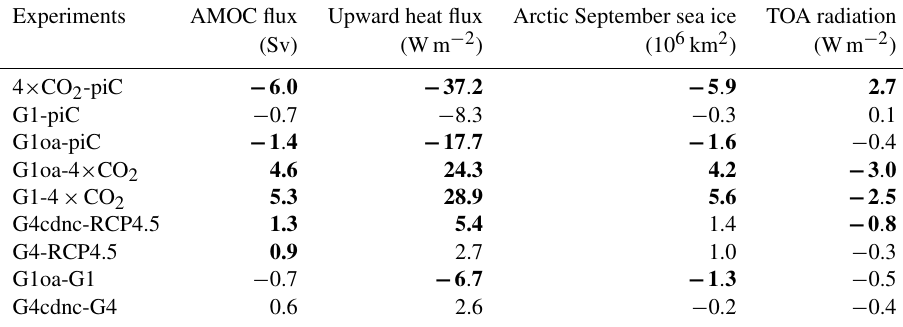
Figure 1. Schematics of the four experiments outlined in this paper, based on Kravitz et al. (2011, 2013). (a) G1 is started from a preindustrial control run; longwave forcing (blue) from quadrupled GHG forcing is compensated by a fixed reduction in the solar constant (red) to leave net zero forcing (black); the experiment is for 50 years duration. (b) In G1oceanAlbedo the equivalent balance is obtained by an increase in ocean albedo. (c) G4 is started from 2020 and ends in 2069, branching from RCP4.5 with 5Tgyr − 1 SO 2 injected into the equatorial lower stratosphere. (d) In G4cdnc the shortwave forcing comes from a constant 50% increase in cloud droplet number concentration in oceanic low clouds. Table 3. Differences in average AMOC index, upward heat flux (Wm − 2 ), September sea ice extent (10 6 km 2 ) and top-of-atmosphere radiation (Wm − 2 ) over the 40-year analysis period. Bold entries denote differences significant at the 95% level in the Wilcoxon signed-rank test. G1oa refers to G1oceanAlbedo, and piC refers to piControl. Individual ESM results are shown in Tables S2–S5. Experiments AMOC flux Upward heat flux Arctic September sea